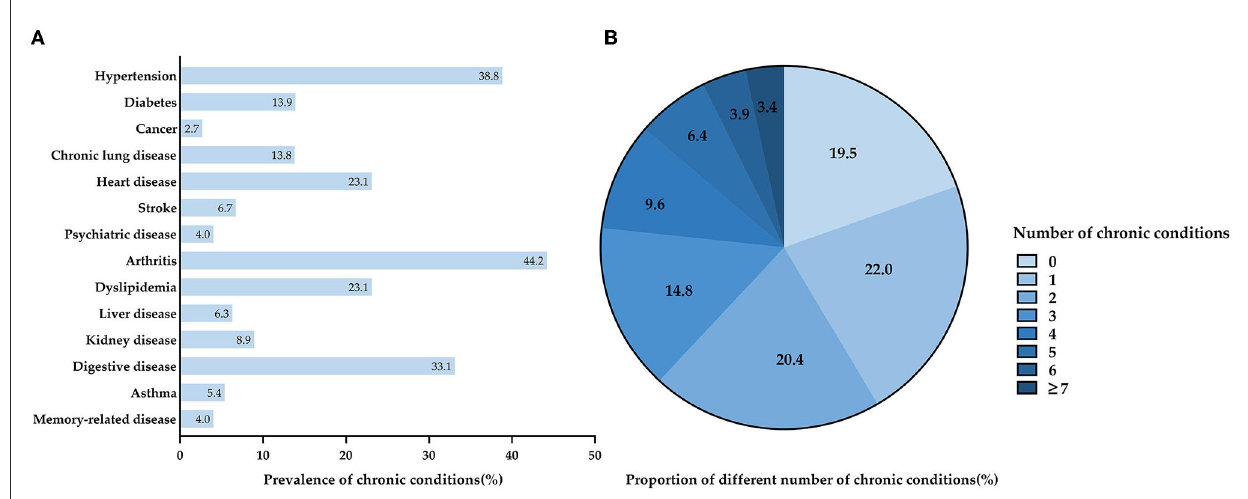
FIGURE1 Prevalence of multimorbidity and the distribution of chronic diseases of participants. (A) Prevalence of chronic conditions among participants in this study. (B) The proportion of different numbers of chronic conditions among participants in this study.